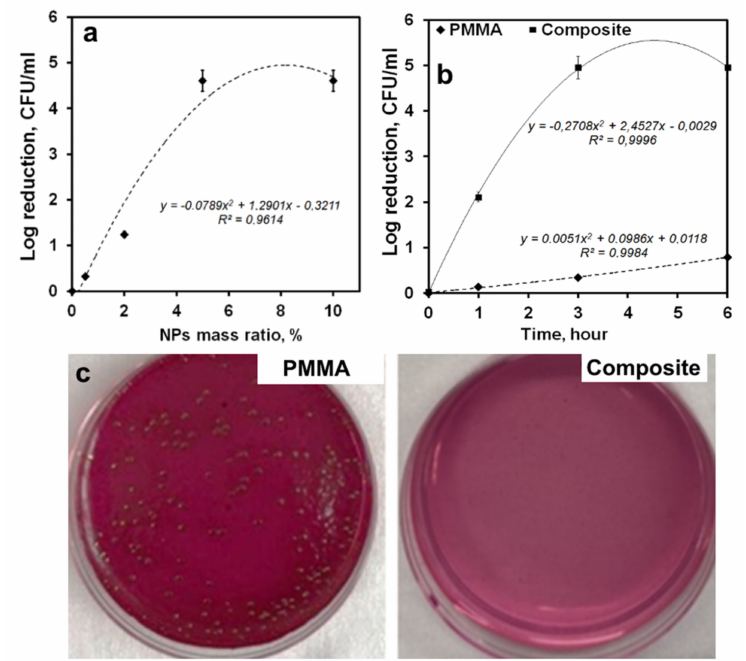
Figure 8. E. coli log reduction after exposure on the surface of the composites with different NP mass ratios ( a ). Time-dependent E. coli log reduction after exposure on the surface of the PMMA and composite, containing 5 wt.% NPs ( b ). Photographs of typical Petri dishes after 3 h exposure of E. coli on the surface of the PMMA and composite, containing 5 wt.% NPs ( c ).